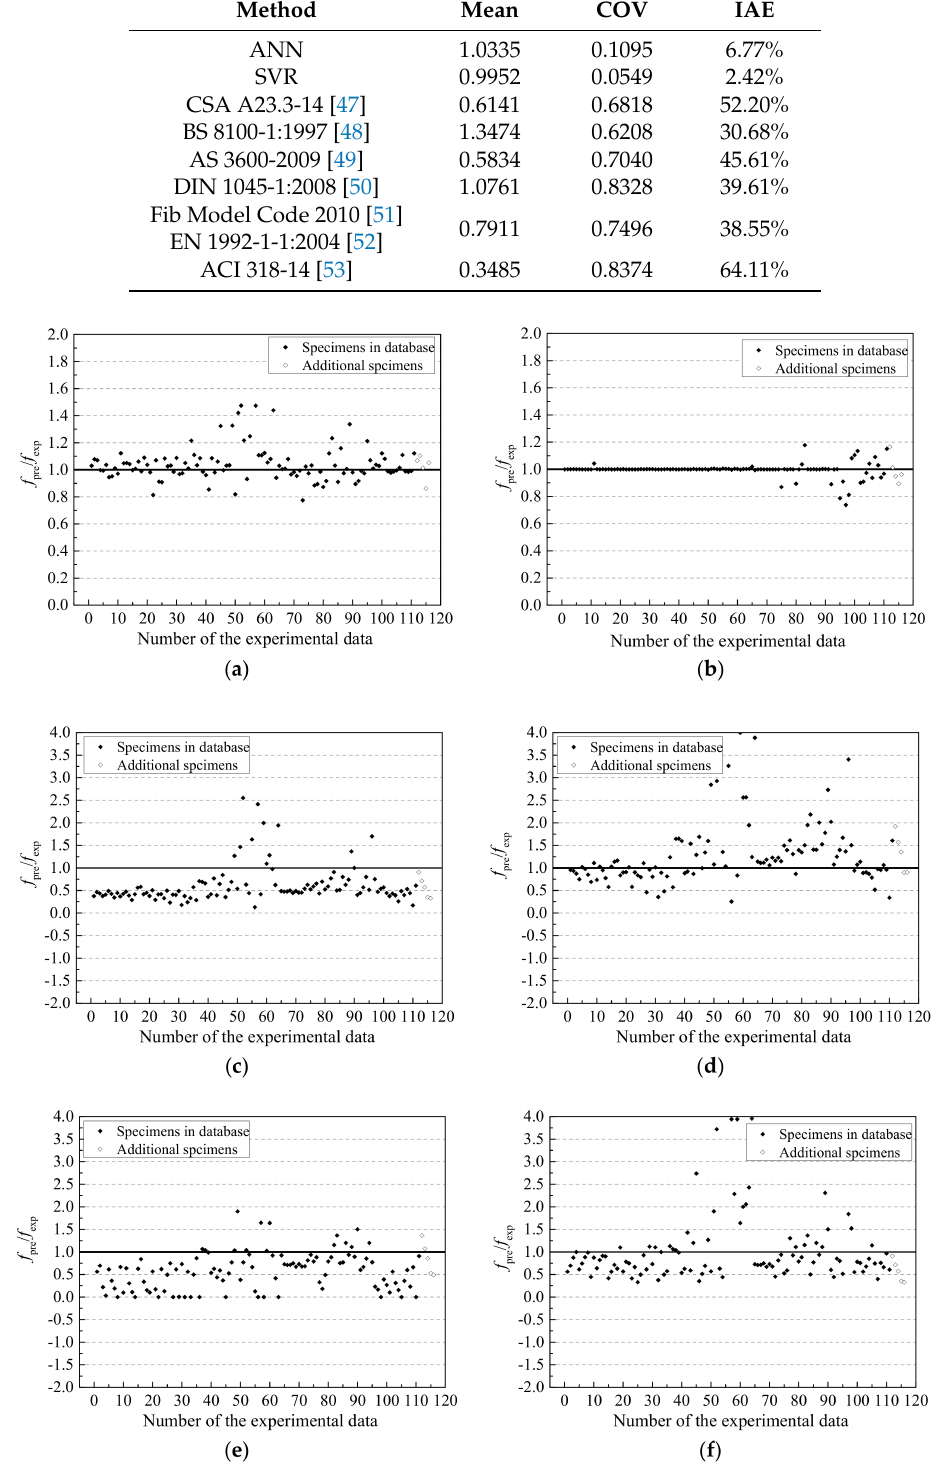
Table 9. Comparisons between ANN, SVR models and methods specified in the design codes.